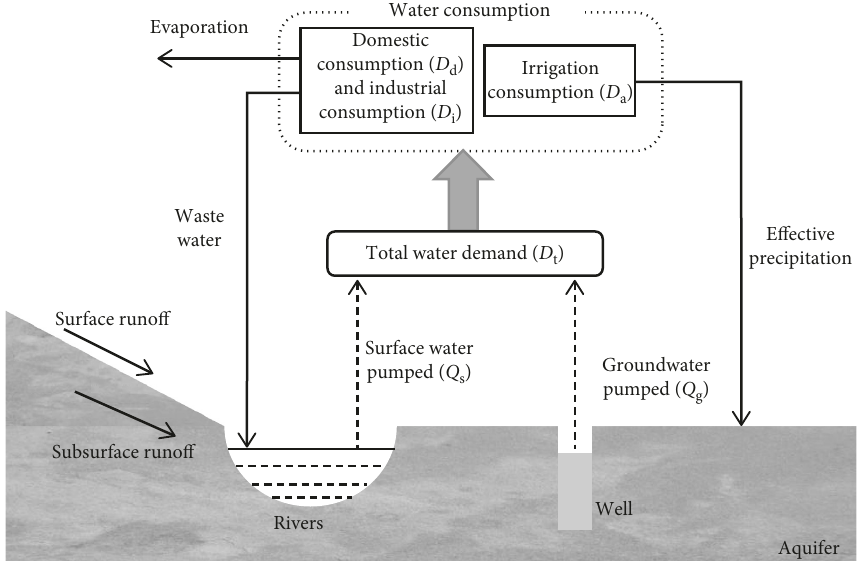
Figure 2: Framework of the water exploitation and consumption